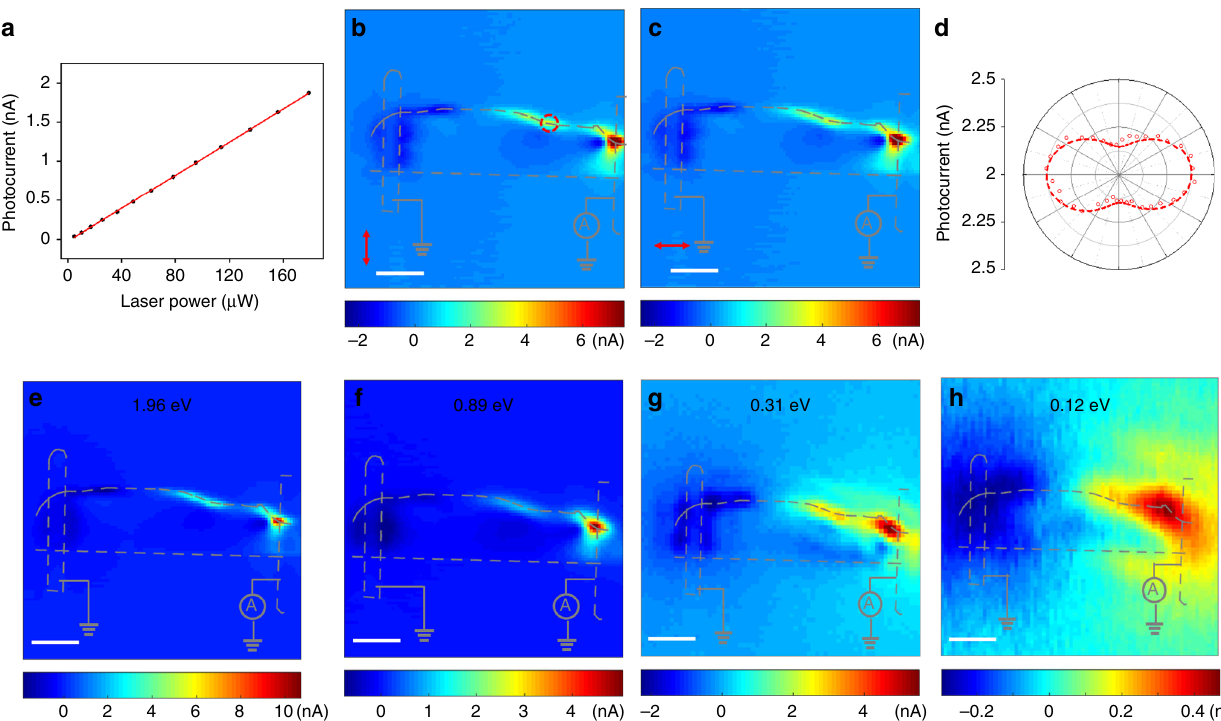
Fig. 4 Excitation power and polarization dependence of edge photocurrent. a Power dependence of the edge photocurrent responses with 1.96-eV pulse excitation. b , c Scanning photocurrent microscopies under horizontal- ( b ) and vertical-polarized ( c ) light excitation respectively. The light polarization is marked by the red arrows. d Polarization dependent photocurrent responses with light focused on the spot marked by a red circle in Figure b. e – h Scanning photocurrent microscopies with excitation photon energies of 1.96 eV ( e ), 0.89 eV ( f ), 0.31 eV ( g ) and 0.12 eV ( h ) respectively. All measurements were performed on the device shown in Fig. 2a. The scale bars are all 8 μ